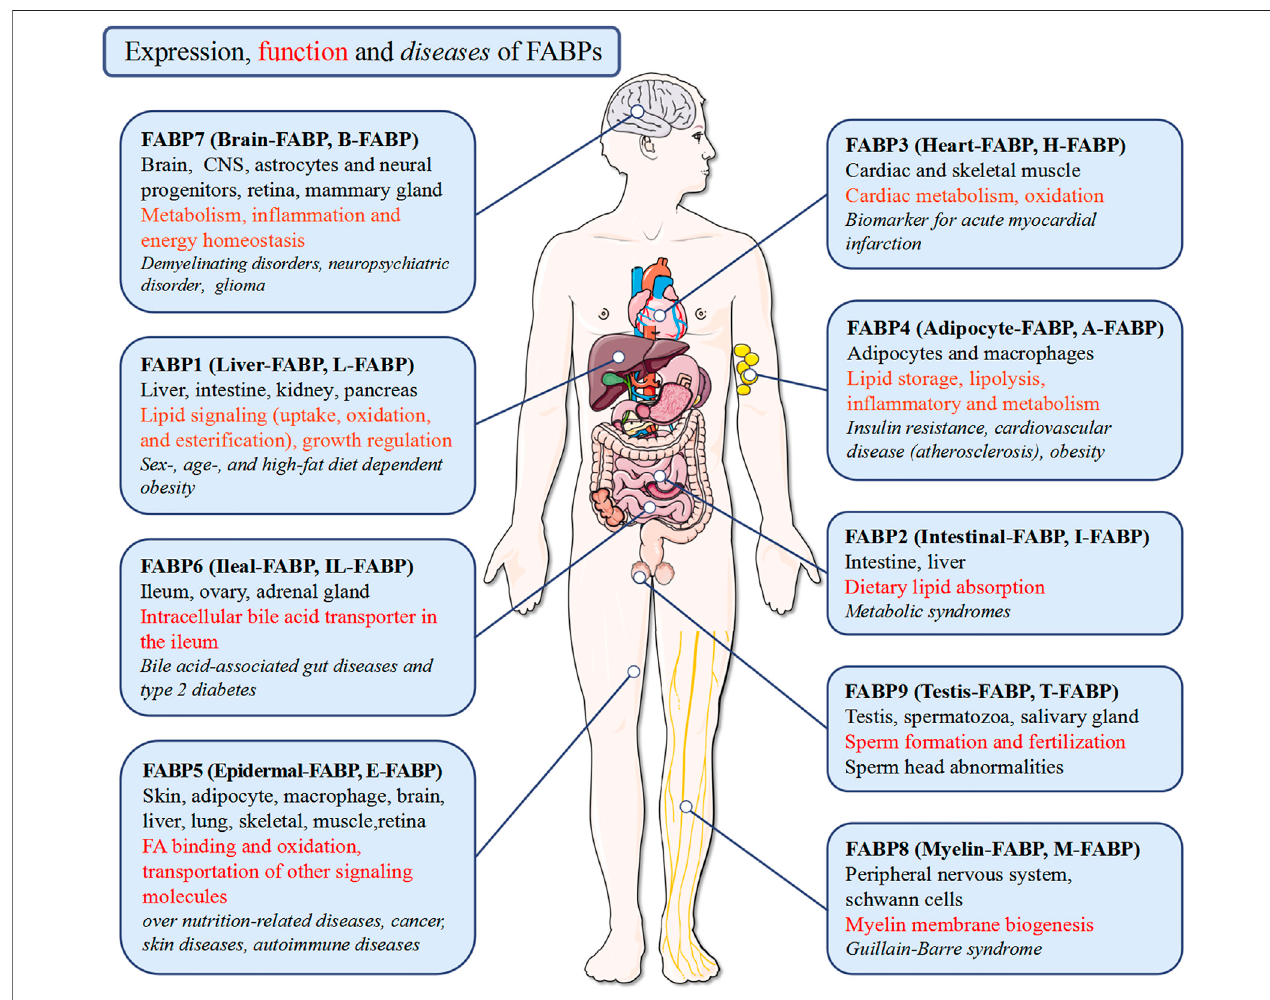
FIGURE 3 | Expression, function and diseases of FABPs. FABPs function pleiotropically in human body to maintain tissue homeostasisin health and toparticipate in disease pathogenesis.